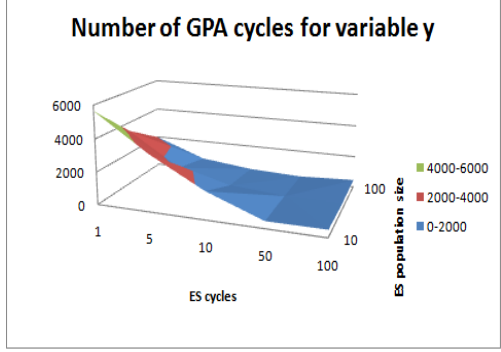
Fig. 4: Number of iterations of encapsulating GPA for y variable depending on ES cycle limit and ES population size.